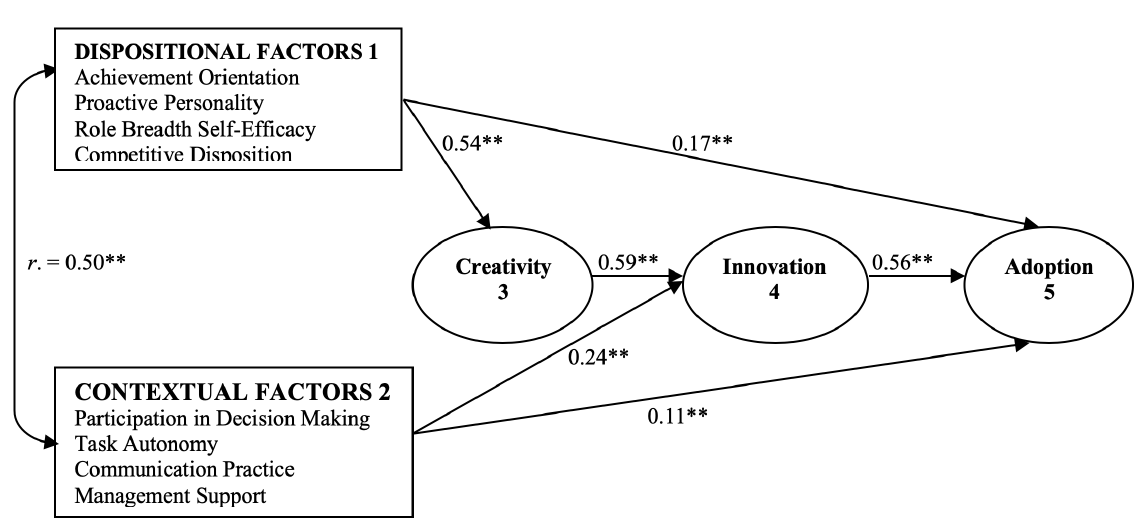
Fig. 2. Path Diagram of the Hypothesized Model of Employee Innovation Process Showing Path Coefficients.